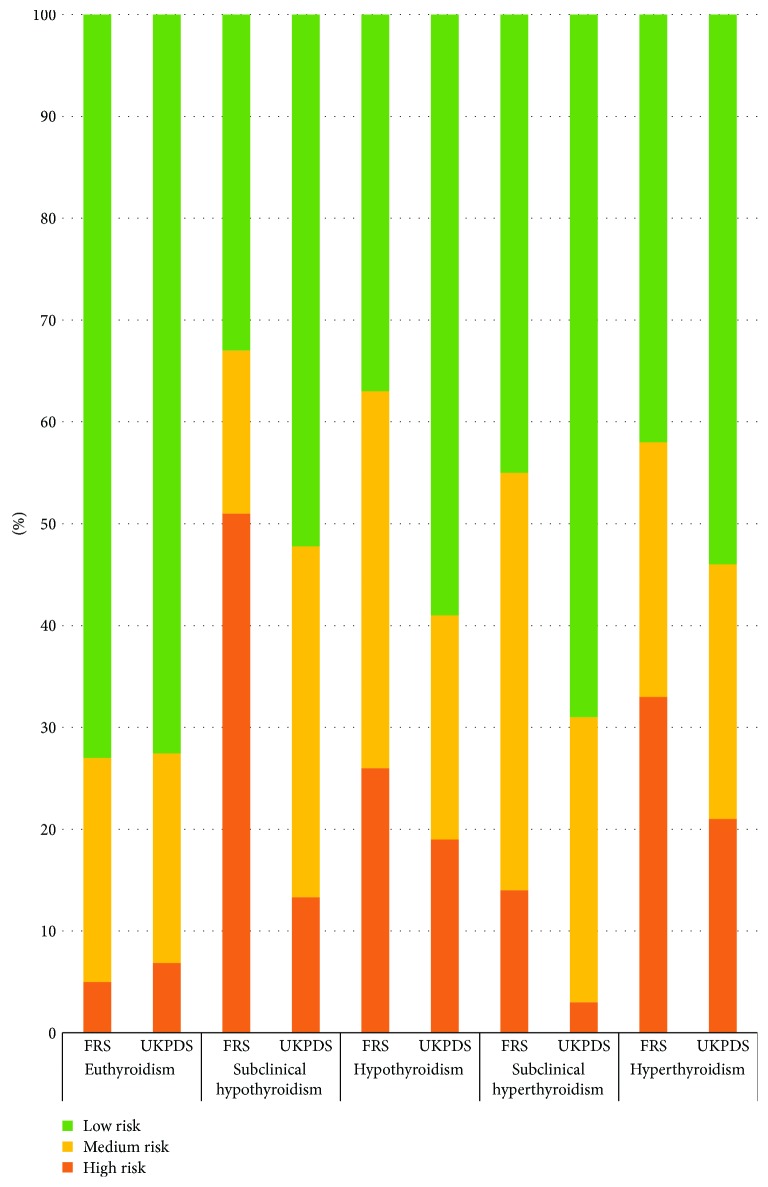
Variation of coronary heart disease risk per Framingham and UKPDS Scores.